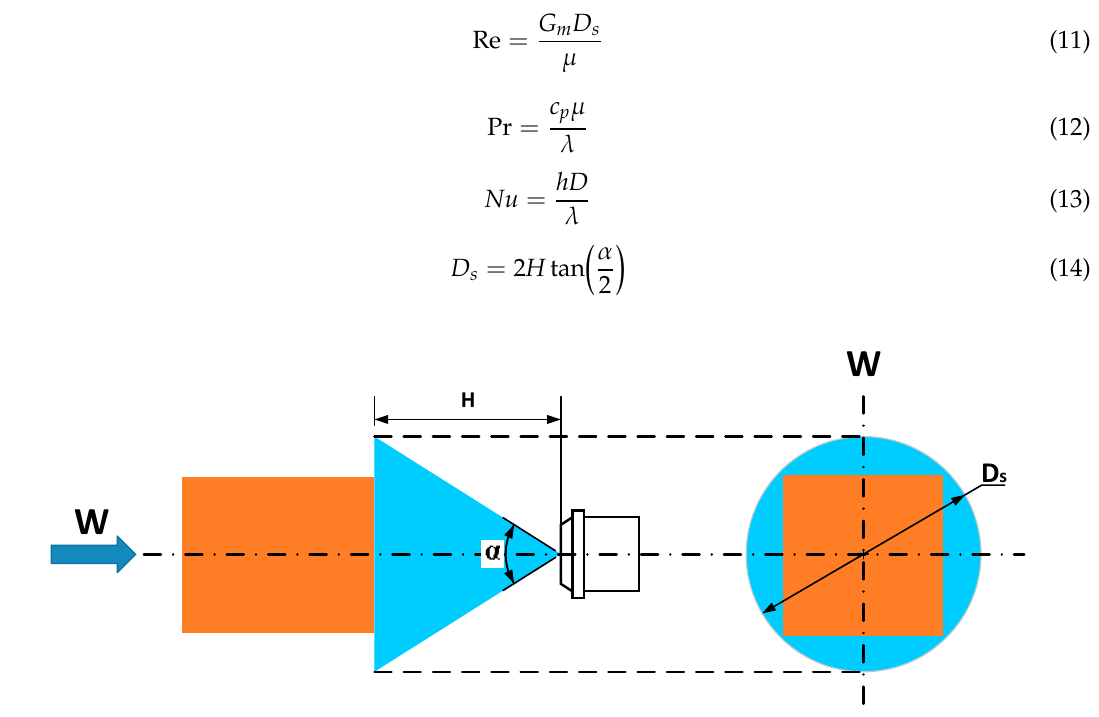
Figure 9. Schematic and simplified version of projection diameter.